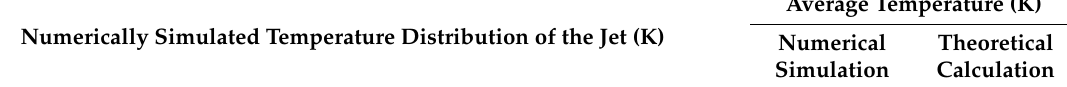
Table 4. Temperature distribution of the jets at 40 µ s and data